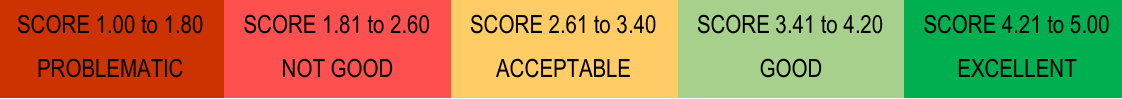
Table 10. Example of sub-domain results per position (Score from 1 to 5).